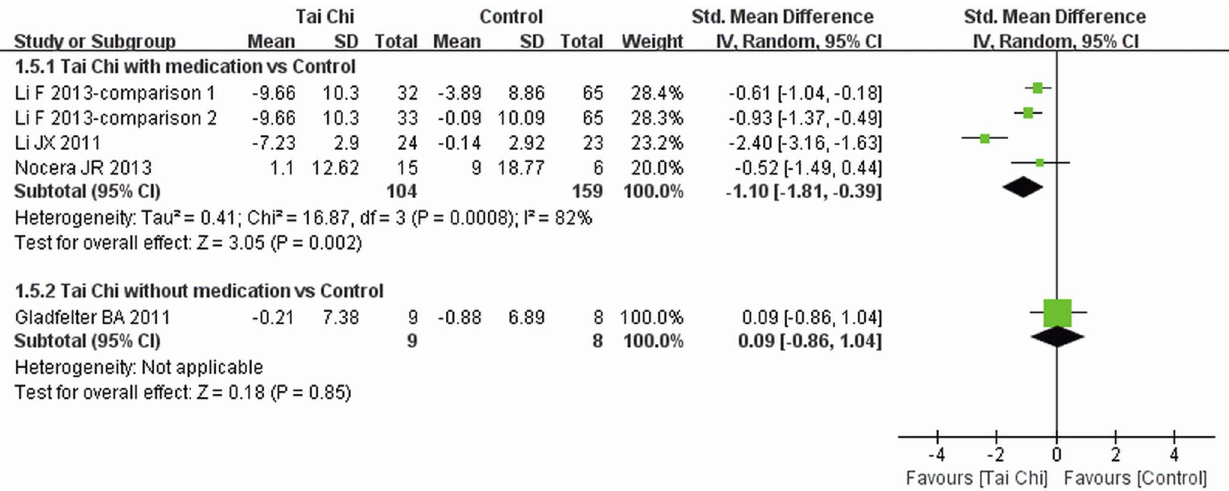
Figure 7. The effect of Tai Chi on HRQOL. Subgroup analysis was performed according to whether or not medications were included in the intervention. Standardized mean difference was calculated for PDQ-39 (short and long versions) and PDQ-39SI scores. HRQOL, health-related quality